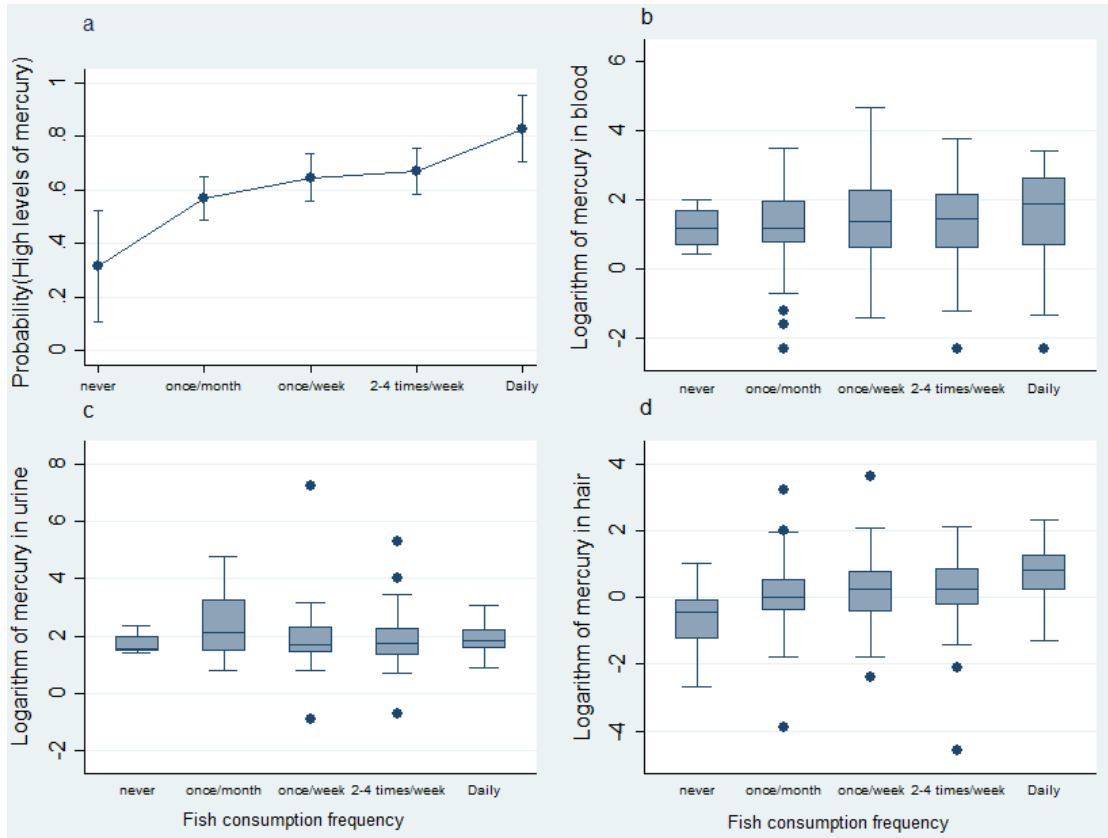
Figure 1. ( a ) Probability of high levels of mercury in at least one of the matrices evaluated. ( b ) Box diagram for blood mercury levels according to frequency of fish consumption. ( c ) Box diagram for mercury levels in urine according to frequency of fish consumption. ( d ) Box diagram for mercury levels in hair according to frequency of fish consumption.